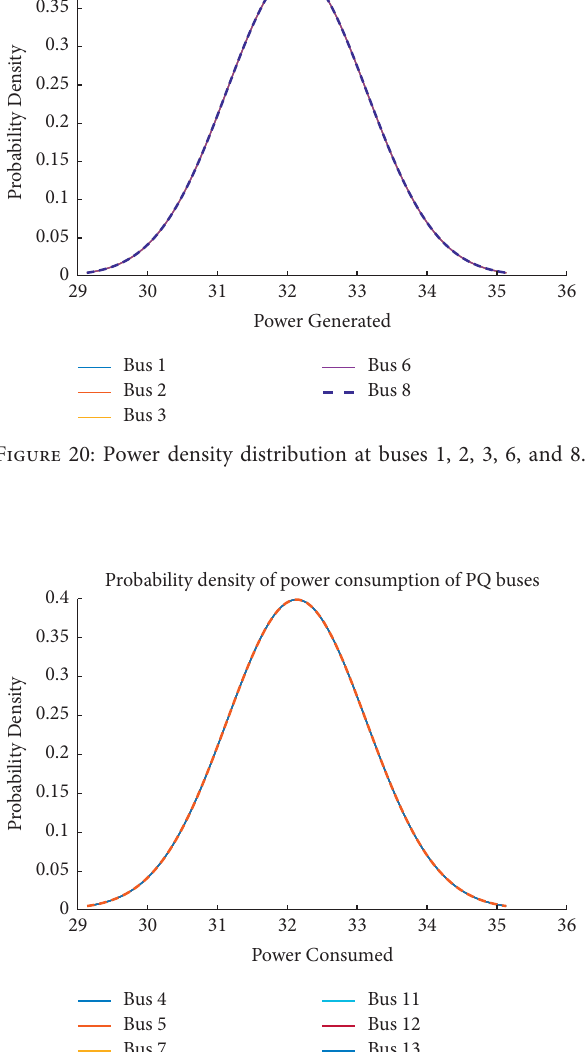
Figure 21: Power density distribution at buses 4, 5, 7, and 9–14.